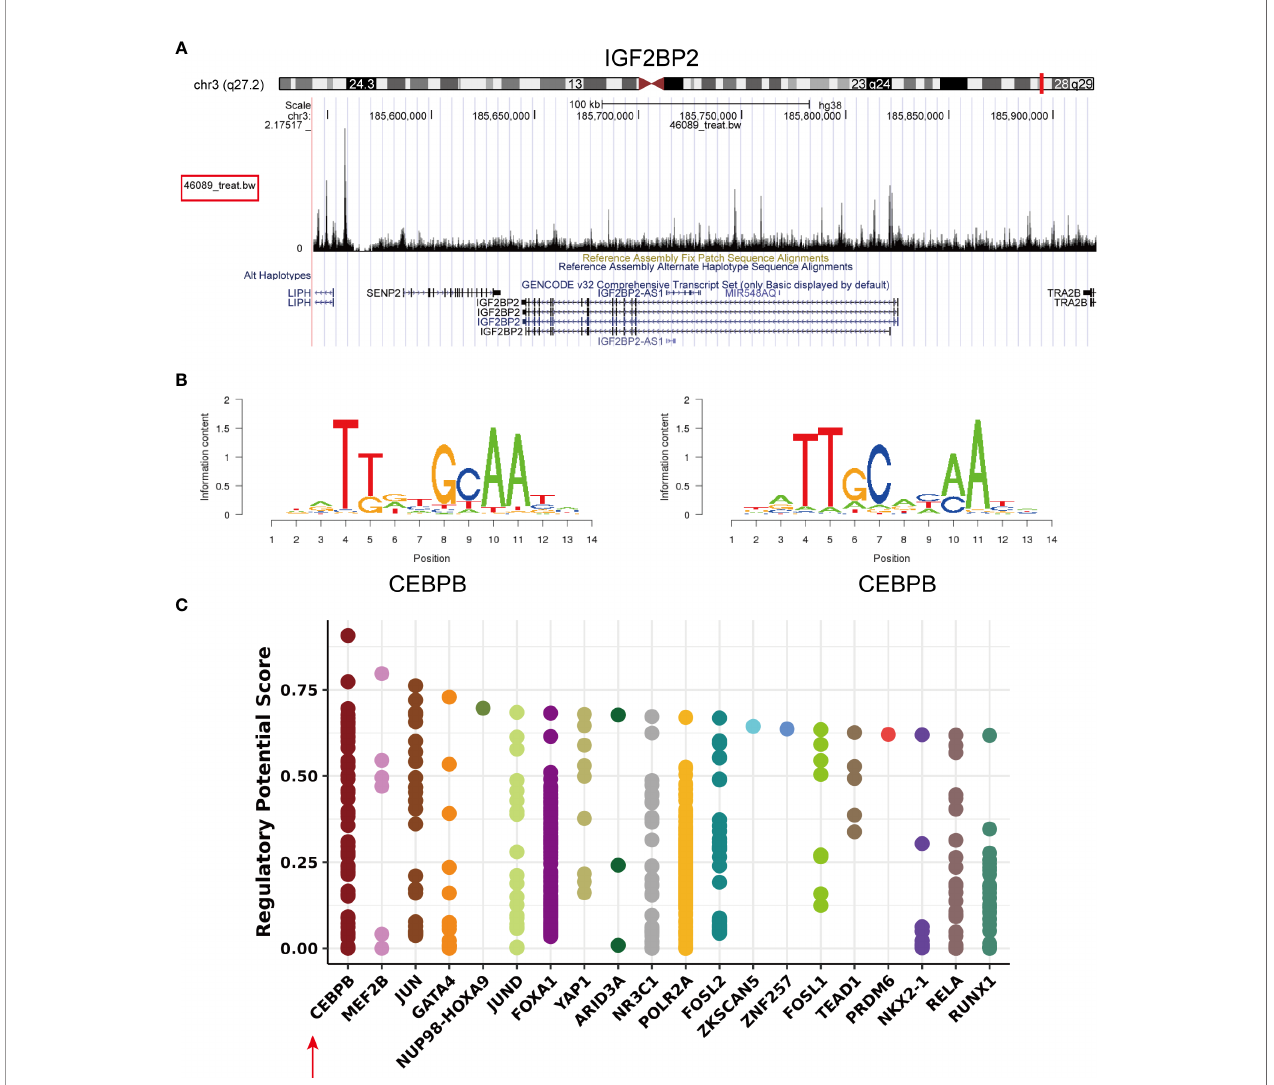
FIGURE 4 | Transcription factor prediction of IGF2BP2. (A) Visual presentation of the high binding peak of the transcription factor CEBPB in the promoter region of IGF2BP2 (B) Representative sequence logo of the binding speci fi city of the transcription factor CEBPB queried from Cistrome. (C) Static plot of the top 20 factors that regulate IGF2BP2. Y axis shows the RP score. X axis shows different factors. Dots on the x axis line indicate the same